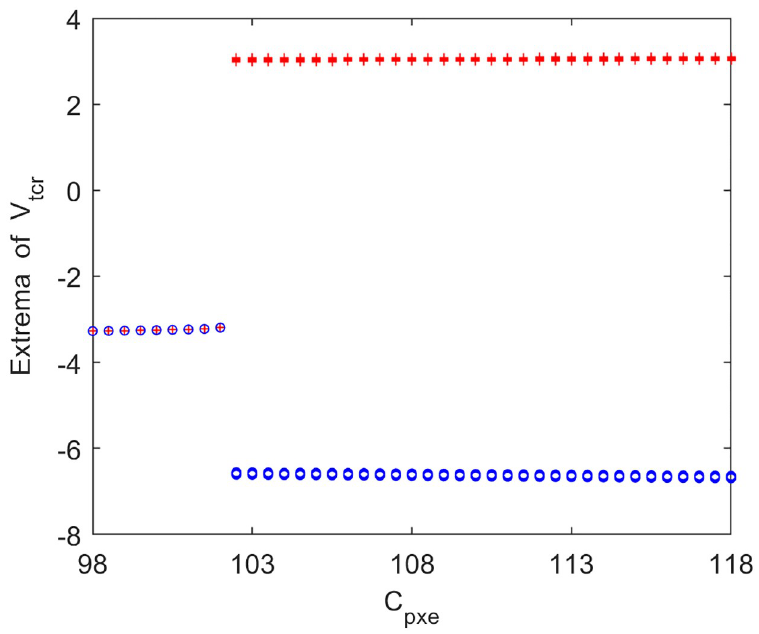
Fig 10. Bifurcation analysis of the thalamic module’s extrema for varying synaptic connection C . Red and blue pxe points indicate the local maximum and minimum of the thalamic output, respectively. https://doi.org/10.1371/journal.pone.0229950.g010 model. To illustrate the above bifurcation phenomenon, Fig 11 describe the phase orbits and the corresponding time series plots when the connection parameter C takes some typical pxe values such as C = 96, 101.9, 102.5, 110. From these figures, it can be found that when C pxe pxe increases to an appropriate value ( C � 102.5), the phase orbit of the model changes from a pxe